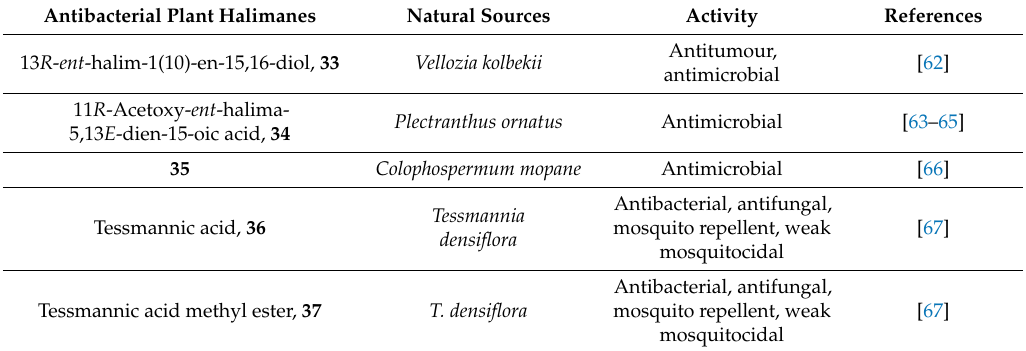
Table 5. Natural sources, activities of antibacterial halimanes from plants Antibacterial Plant